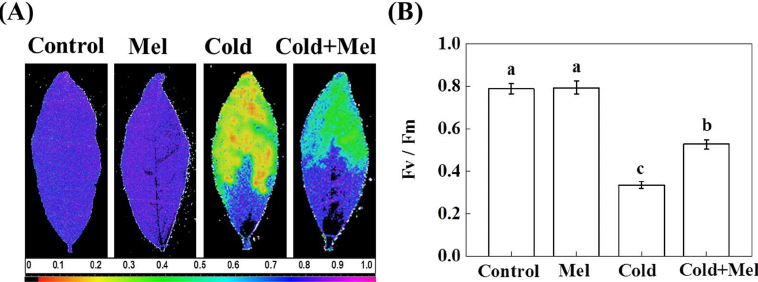
Figure 2. Effect of melatonin application on the maximum photochemical efficiency of PSII (Fv/Fm) in tea leaves under normal and cold stress conditions. ( A ) Pseudo color image of Fv/Fm; and ( B ) Fv/Fm value under different treatments. Pseudo color gradient shown at the bottom of the image ranges from 0 (black) to 1 (purple). Mel, melatonin. Each data point presents the mean of six replicates (± S.D. (standard deviation)). Means denoted by different letters are significantly different ( p < 0.05) based on the Tukey’s test.